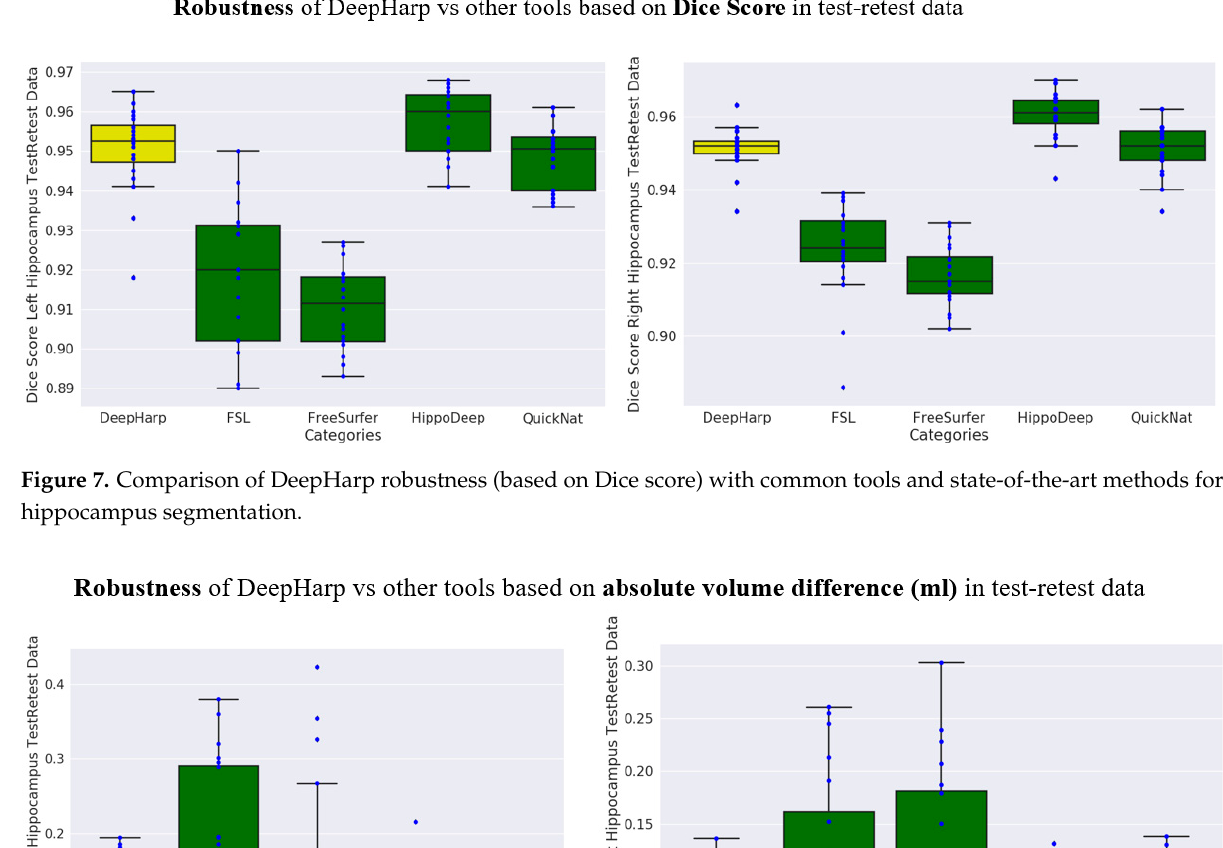
Figure 6. Comparison of segmentations for different tools for a selected patient and slice. It can be seen that Freesurfer and FSL show more false positives than other tools at the head of hippocampus. Freesurfer also has more false negatives at the tail than other tools.